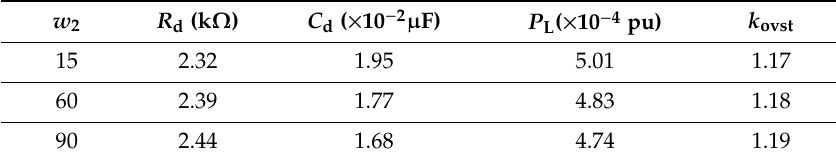
Table 7. E ff ects of w 2 on Optimization Results.